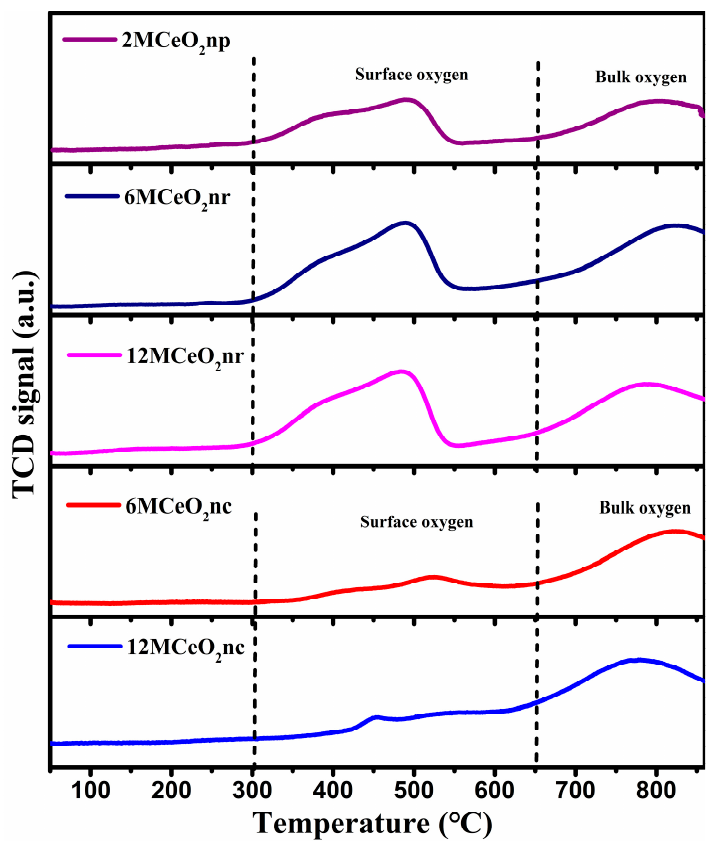
Figure 3. H 2 − TPR profiles of CeO 2 nanomaterials. Figure 3. H − TPR profiles of CeO 2